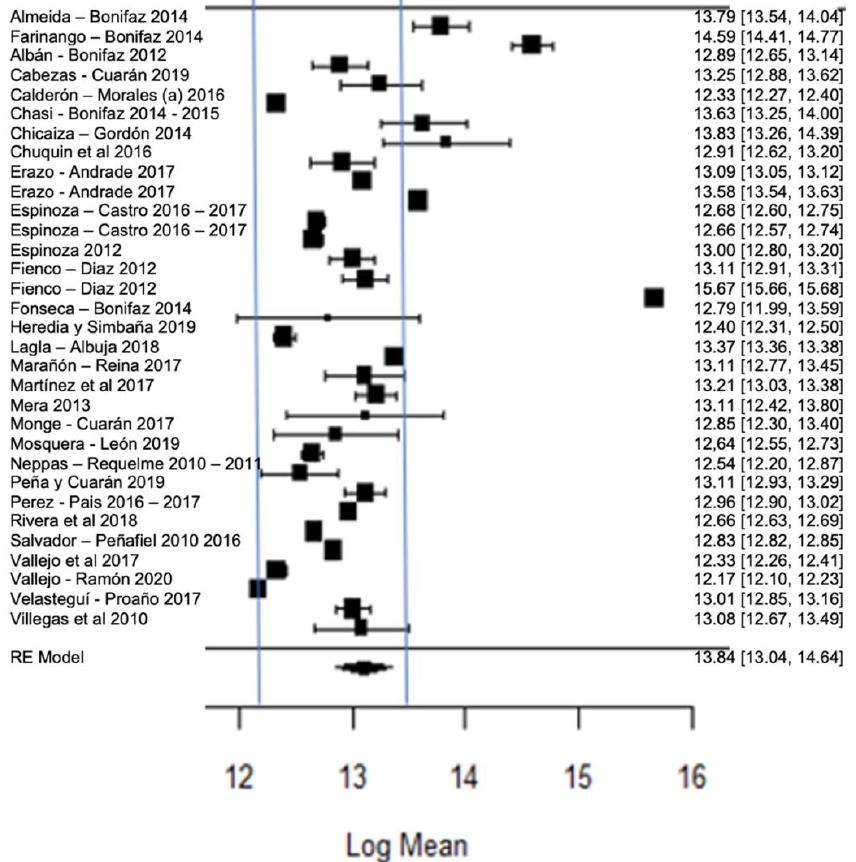
Figure 14. Forest plot of somatic cell counts [14,23 – 29,33,35,38,39,47,52 – 54,56,58,61,63,64,66 – Figure 14. Forestplotof somatic 68,71,73,76,77,80].